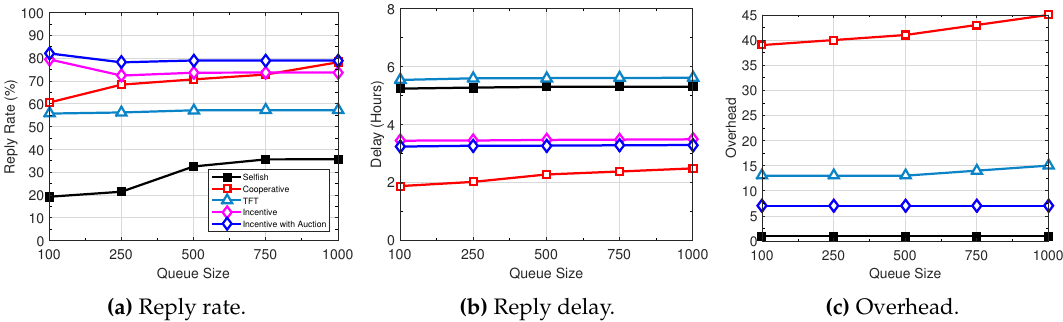
Figure 7. Performance trend with increasing queue size.